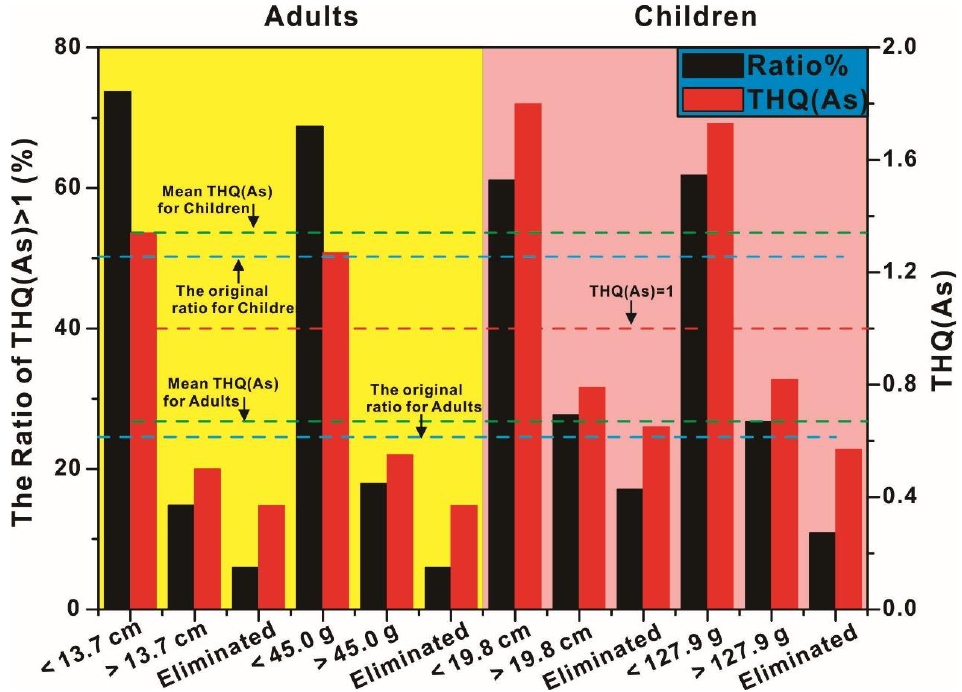
Figure 5. The variation of THQ in screened fish and unscreened fish. Note: Eliminated means Oreochroms mossambcus was eliminated from size screened fish.